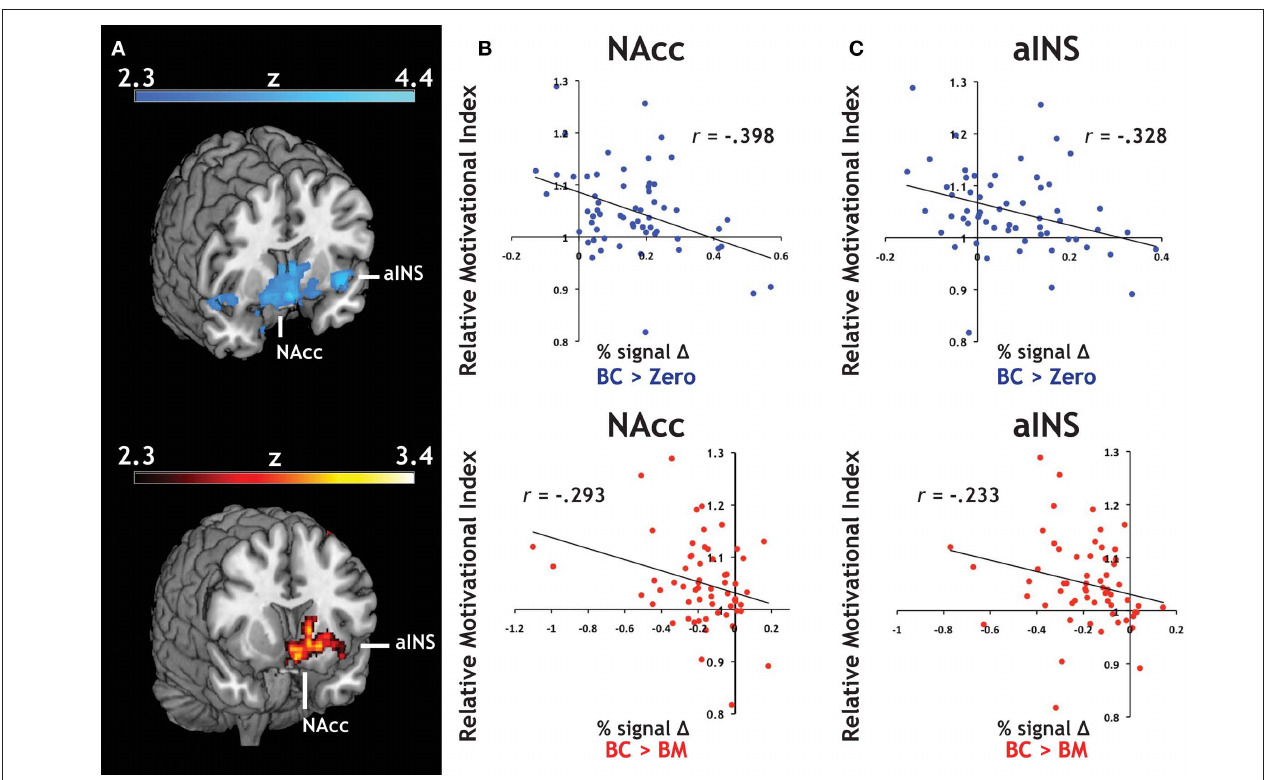
each participant’s motivational measure (i.e., the relative motivational index, RMI) as a covariate in the across-participant analysis of our reward anticipation task. For both of our a priori regions of interest, (B) the NAcc and (C) the aINS, we found a significant relationship between RMI and both BC > Zero (blue) and BC > BM (red).